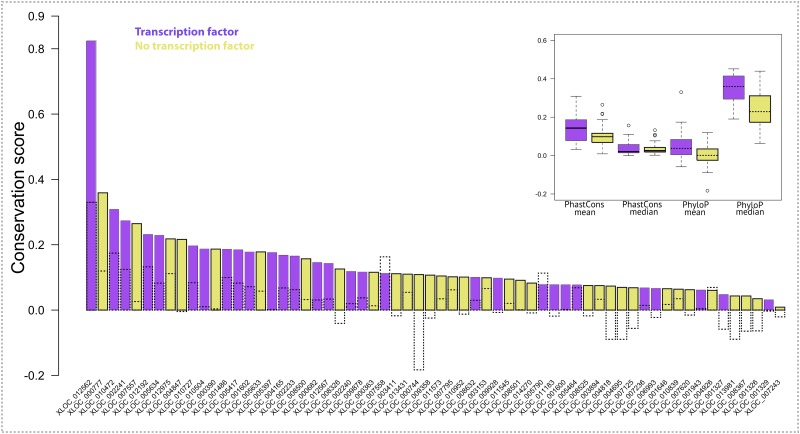
Sequence conservation among primates for lincRNAs expressed during human neurogenesis tends to be higher for lincRNAs flanked by at least one transcription factor.PhastCons scores are shown for 62 lincRNAs, whose gene-neighborhoods are not conserved in mouse (S2 Table). PhyloP scores for the same lincRNAs are shown as dotted bars. (Inset) Boxplot of the mean and median PhyloP and PhastCons scores for primates for the 62 lincRNAs. Mean conservation scores between lincRNAs with (purple) and without (brown) at least one adjacent transcription factor were significantly different for both PhastCons (T = -2.371, P = 0.023) and PhyloP (T = -3.513, P = 0.001), but median scores were significantly different only for PhyloP (T = -5.211, P < 0.001).